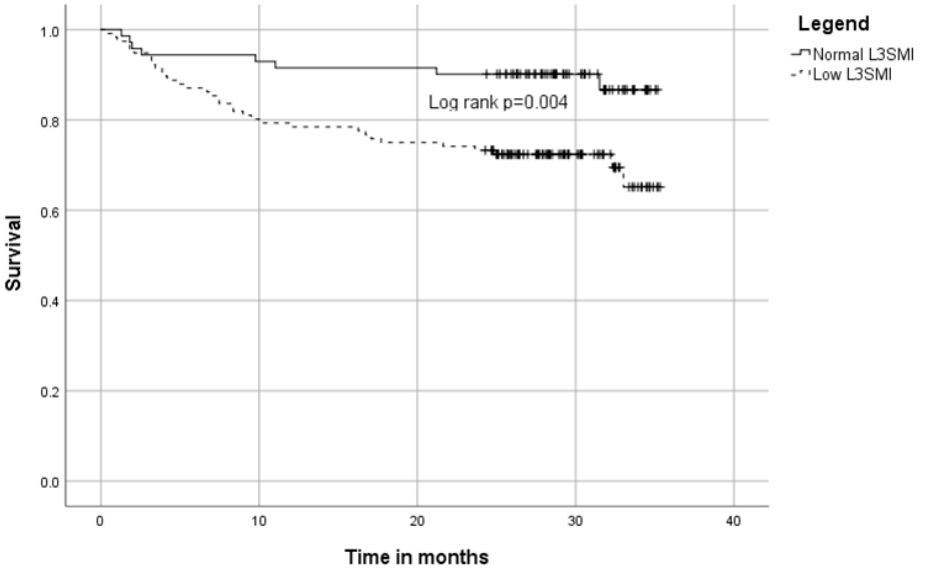
Figure 1. Kaplan–Meier plot of low L3SMI and mortality. Additional predictors of long-term mortality in our cohort were hemoglobin levels, albumin levels, age, pre-existing diabetes mellitus, and high Norton and Morse scales scores. Congestive heart failure and chronic renal failure were predictors of one-year sur- vival but not all-time survival (Table 2). Table 2. Association with survival—Univariate analysis.